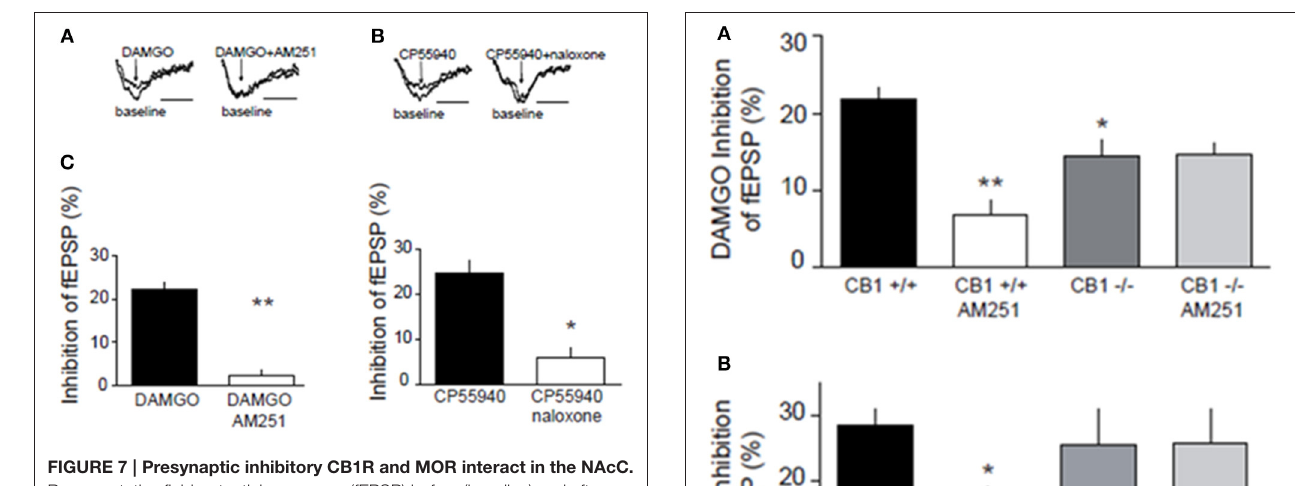
FIGURE 7 | Presynaptic inhibitory CB1R and MOR interact in the NAcC. Representative field potential responses (fEPSP) before (baseline) and after drug application (arrow) (A,B) . The CB1R antagonist AM251 blocked the fEPSP inhibition induced by the selective MOR agonist DAMGO in rat NAcC slices ( C , left panel). Conversely, the OR antagonist naloxone prevented the inhibition of fEPSP induced by the CB1R agonist CP55940 in rat NAcC slices ( C , right panel). Data represent mean ± S.E.M. percent fEPSP inhibition after drug application. * p < 0.05; ** p < 0.01 vs. DAMGO and CP55940. N = 5–8 per treatment group.